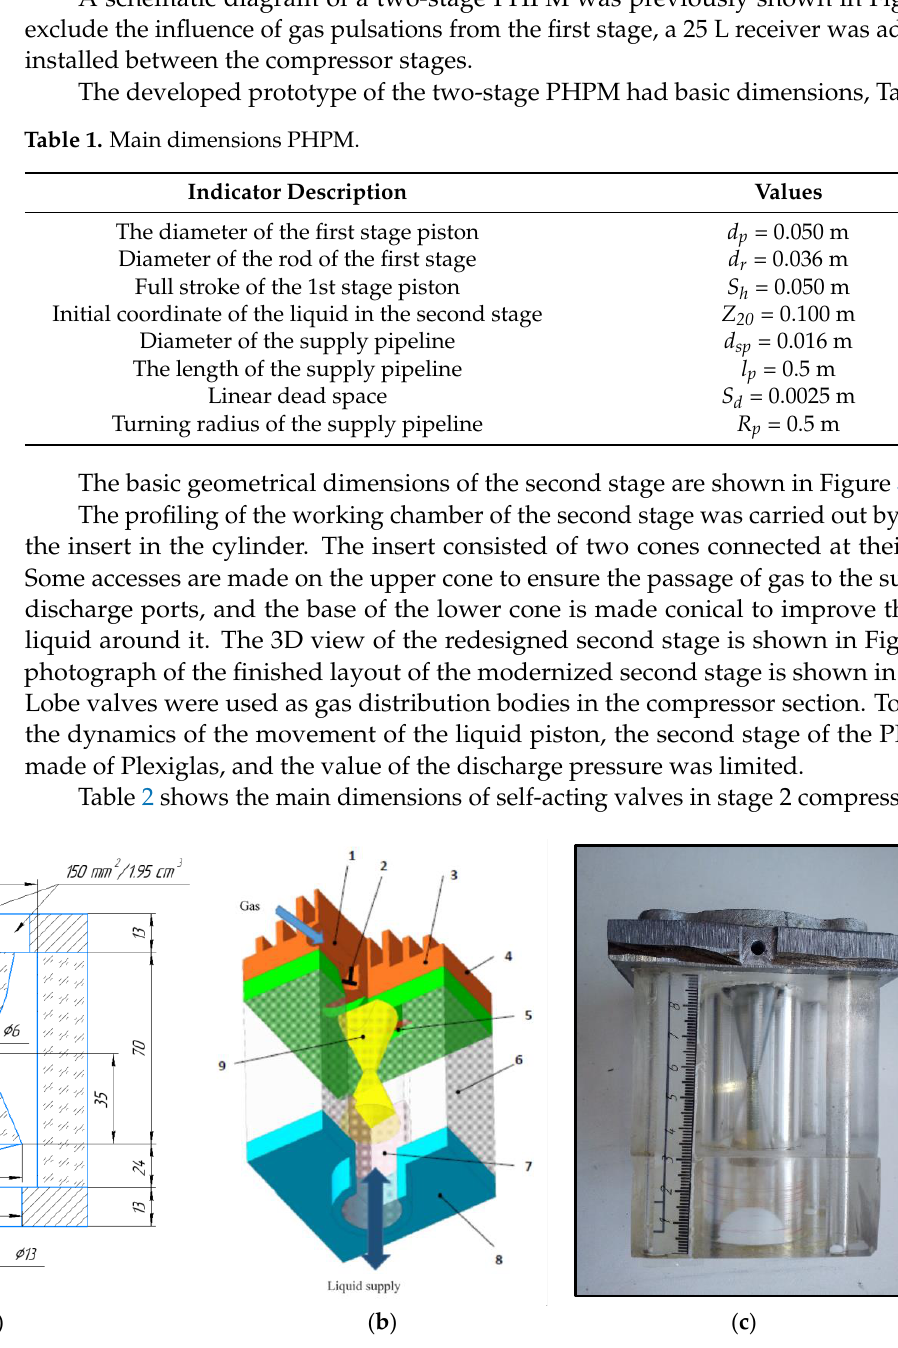
Table 2. Size dimensions of self-acting valves of stage 2 compressor section. Indicator Description